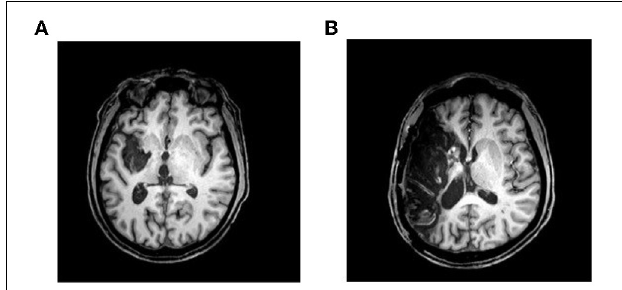
FIGURE 1 | Structural images of the left hemisphere lesions for participants (A) GOE and (B) AMC. Participant AMC had a titanium mesh plate inserted into his left temporalis muscle following his stroke. The metal inserted into AMC’s skull interfered with the MRI scan of that left region and, therefore, it is difficult to pinpoint the exact location of his lesion on the